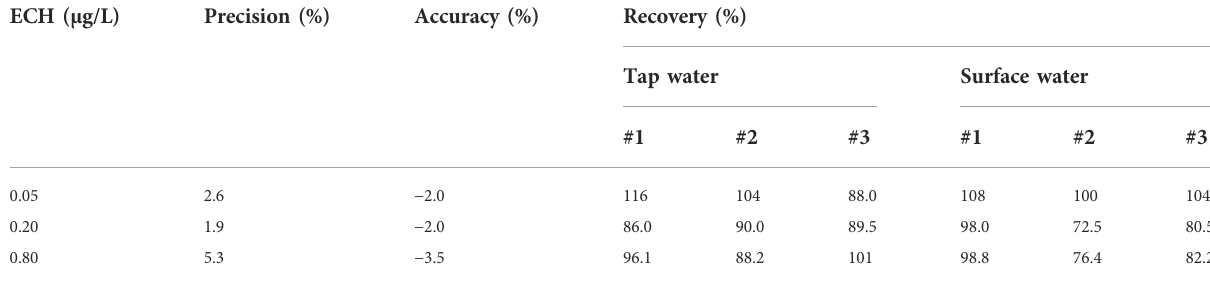
TABLE 1 The precision, accuracy, and recovery rate of the developed method with different ECH dosages in tap and surface water. ECH ( μ g/L)